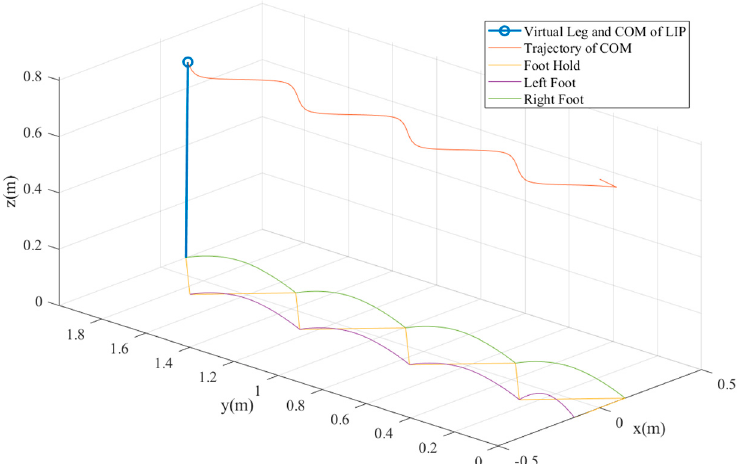
Figure 15. Centroid and foot trajectory.